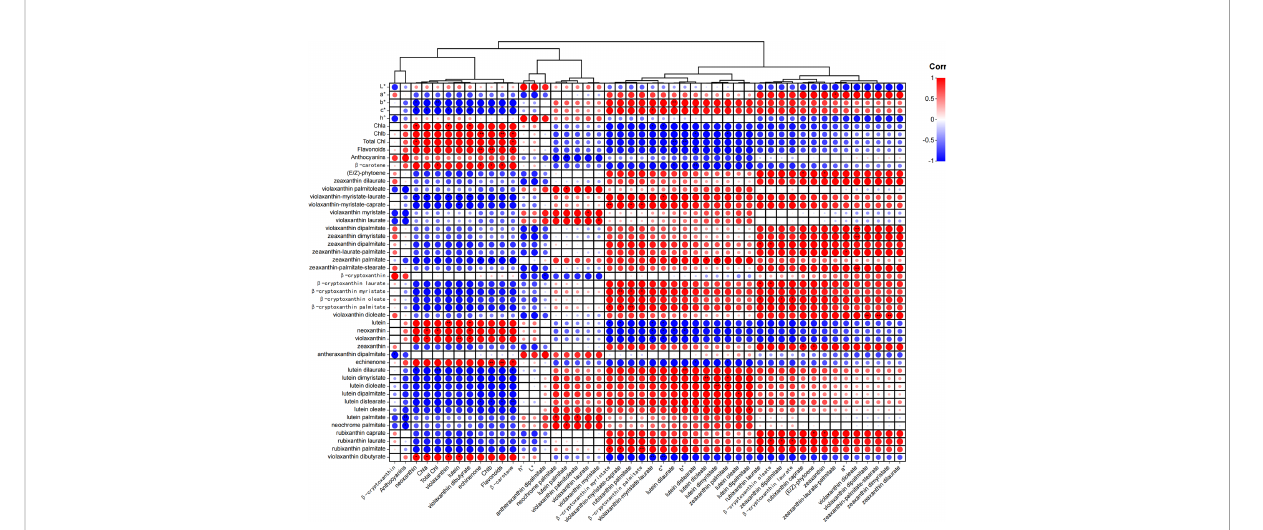
FIGURE 5 Correlation analysis between color difference parameters, carotenoid components and other pigments in HF1. The higher the value of L, the higher the brightness. The larger the value of a*, the darker the red, the smaller the value of a*, the darker the green. The larger the value of b*, the darker the yellow, the smaller the value of b*, the darker the blue. The higher the value of c*, the higher the color saturation. h° values vary from 0° to 180°, with 0° representing fuchsia, 90° representing yellow, and 180° representing green. *means signi fi cant correlation (p < 0.05), ** means greatly signi fi cant correlation (p < 0.01).